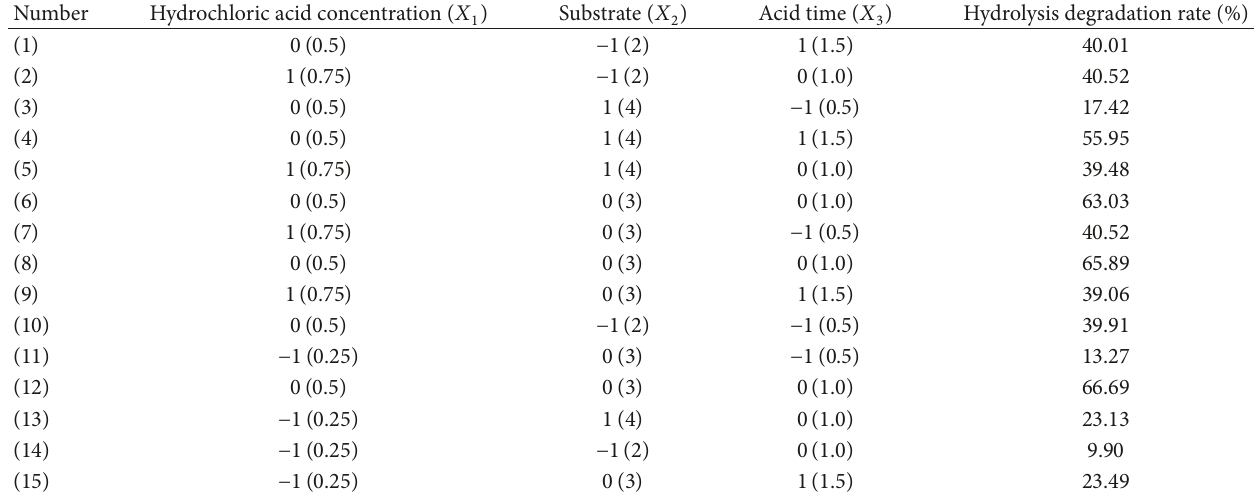
Table 1: Box-Behnken design and observed